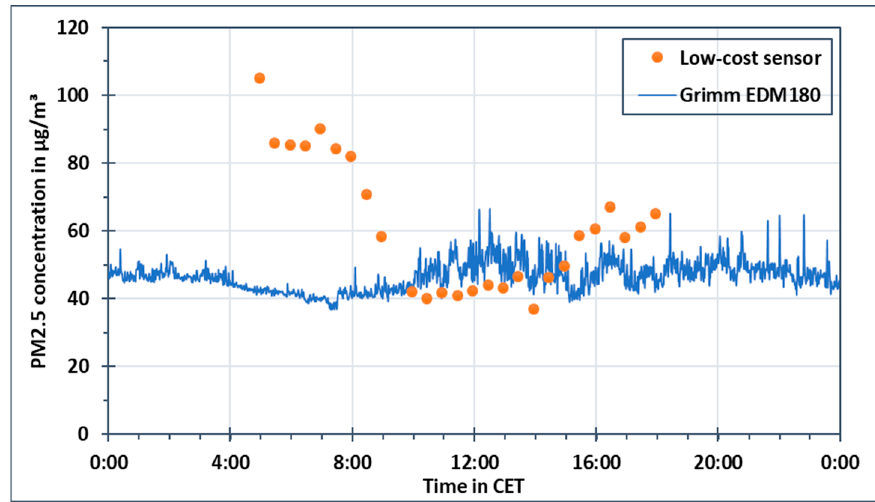
Figure 11. PM2.5 concentration measured using the sensor-monitoring box and aerosol spectrometer Grimm EDM180 on 21 February 2019.